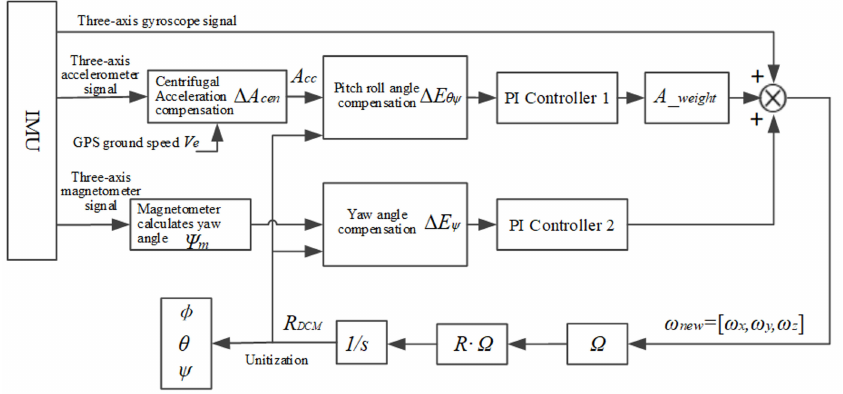
Figure 8. DCM attitude correction diagram of inertial sensor signal correction